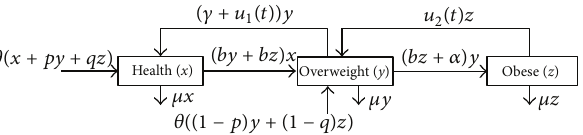
Figure 1: Transmission diagram for obese